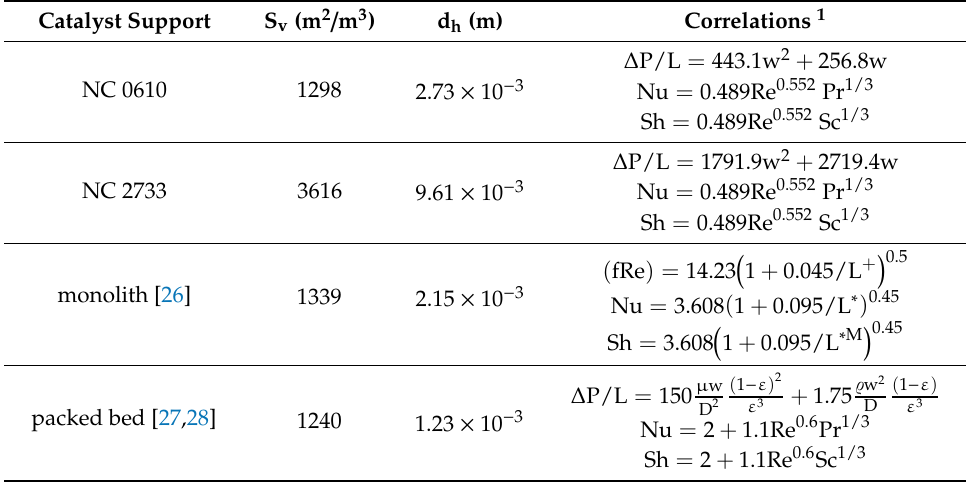
Table 1. Correlations and characteristic parameters for tested catalyst